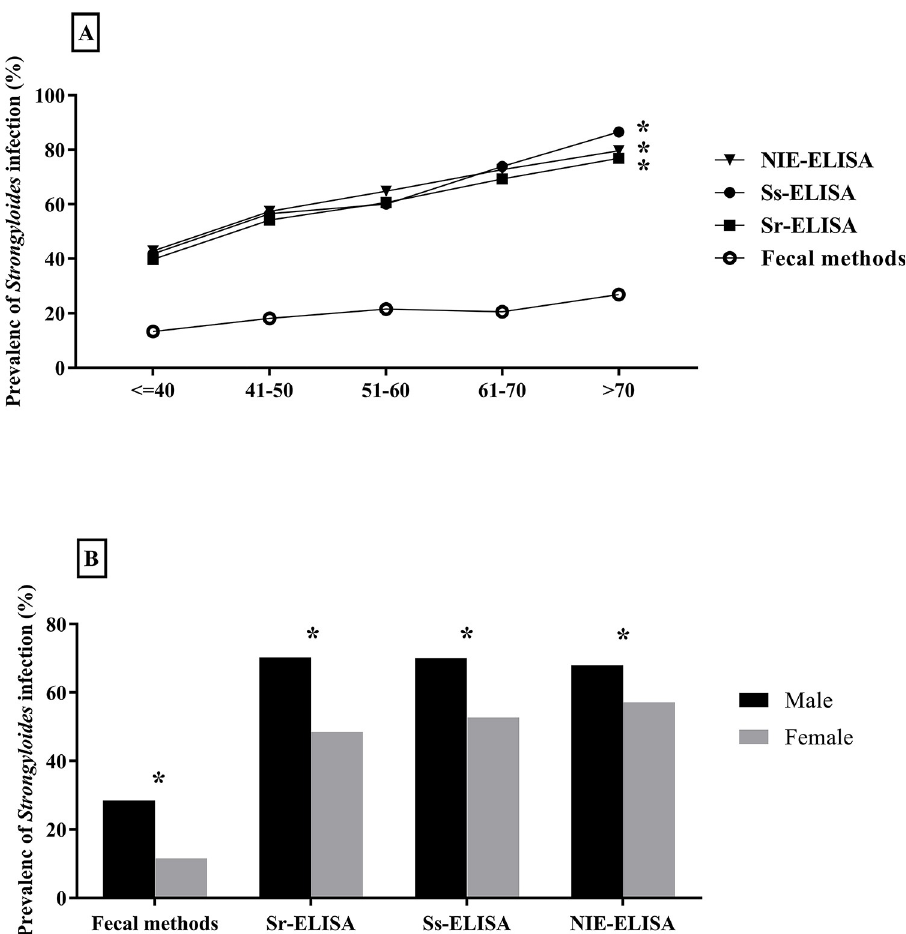
Fig 2. Prevalence profiles of S . stercoralis infection determined by different diagnostic methods arranged by age (Panel A) and gender (Panel B). * Stands for p value < 0.0001 obtained by chi-square test.